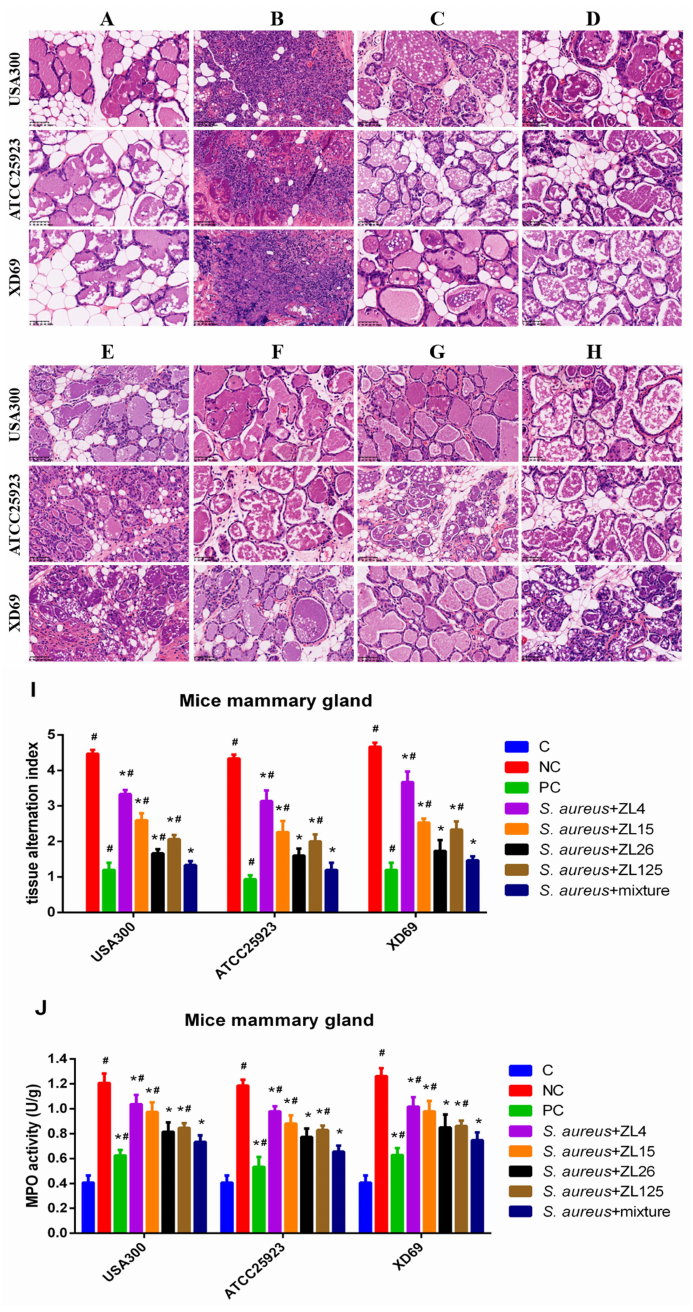
Figure 1. Functions of scFvs on histopathological changes in S. aureus -induced mammary gland tissues by H & E staining. ( A ) Control group; ( B ) negative control group; ( C ) positive control group; ( D ) scFvs mixture group; ( E – H ) single scFv group (ZL4, ZL15, ZL26 and ZL125, respectively); ( I ) Tissue alteration index in mammary gland tissues; ( J ) MPO activity assay. Red arrow was tissue lesion area (red arrow indicates inflammatory cells infiltration in mammary gland tissues). Data repre- sent mean results ± SD ( n = 6). # p < 0.05 vs. scFvs mixture group. * p < 0.05 vs. negative control